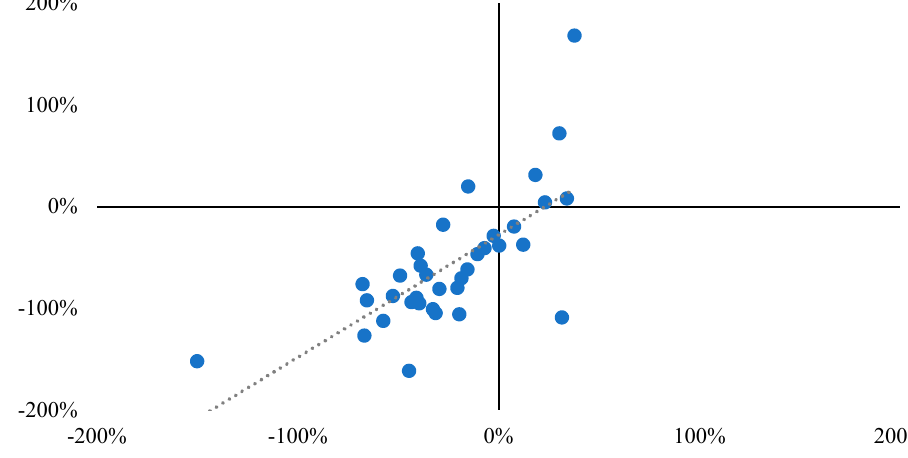
Figure 7. Correlation between total policy effect and demand-side policy factor driving CO 2 334